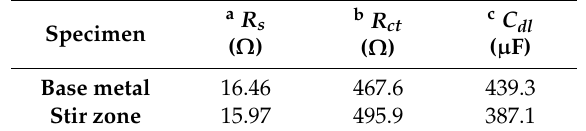
Table 3. Parameters of the replacement corrosive electrical circuit of the electrochemical